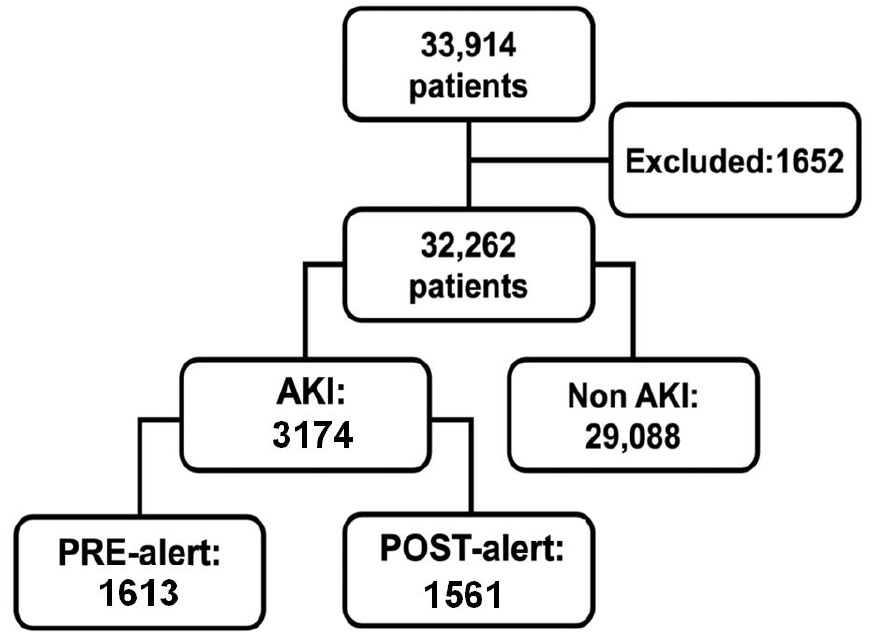
Figure 1. Flowchart of the study population showing the categorization of the 33,914 patients hospitalized in the year 2018. A total of 1652 patients were excluded from this study, and 3174 patients developed AKI; 1613 in the pre-alert period and 1561 in the post-alert period.